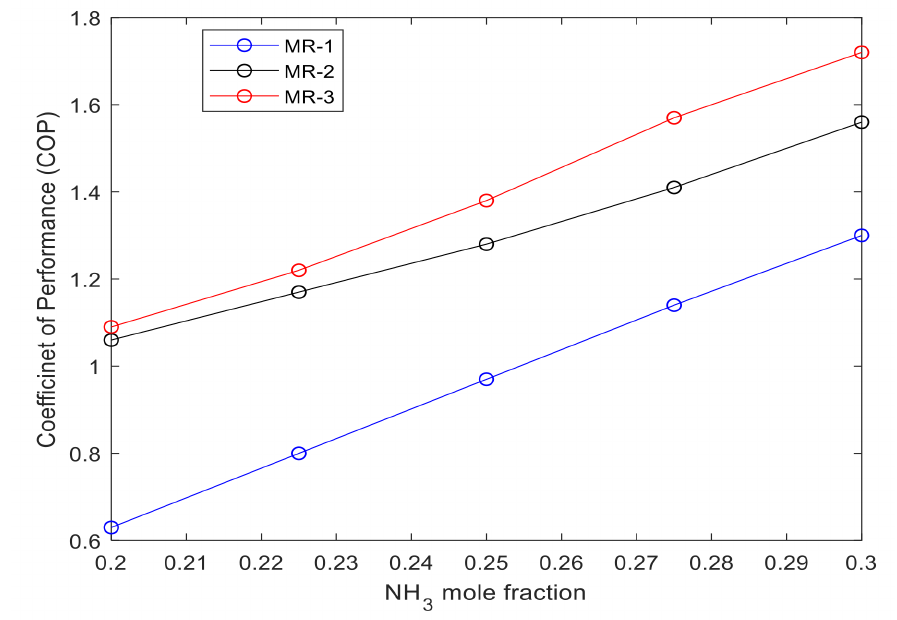
Figure 3. COP of each case study for each group of mixed refrigerant MR-1, MR-2 and